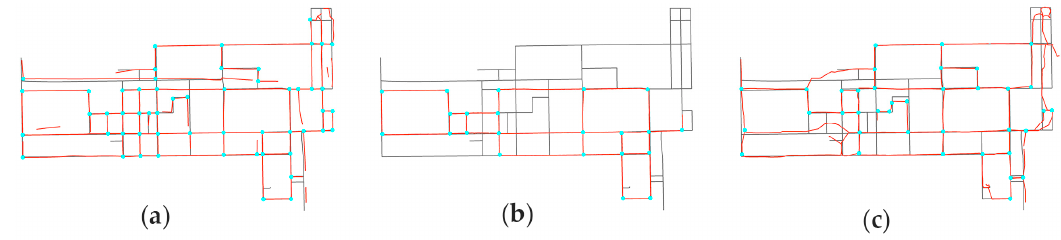
Figure 10. Extracted intersections (highlighted points) and road network (red lines) overlapped with the ground truth map (grey line) of the Chicago dataset. ( a ) Intersections and road network extracted by the proposed method; ( b ) intersections and road network extracted using Davies’s method; and ( c ) intersections and road network extracted using Ahmed’s method.